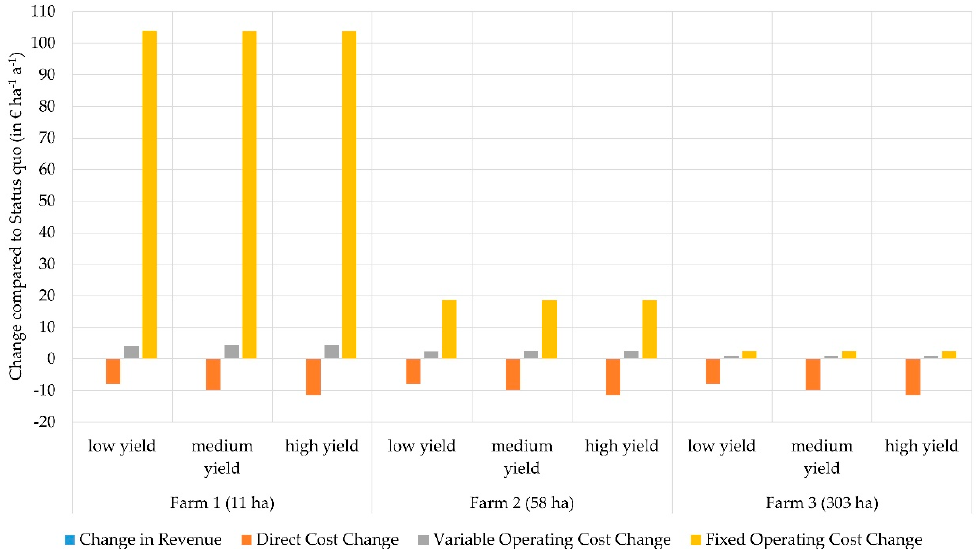
Figure 1. Farm economic changes of the status quo by using an input-saving technology on Farms 1–3 with three different yield levels each (low, medium, high). 1–3 with three different yield levels each (low, medium,